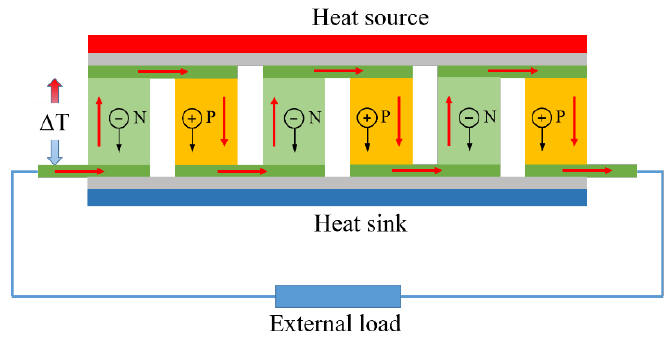
Figure 1. Typical assembly of thermoelectric system.